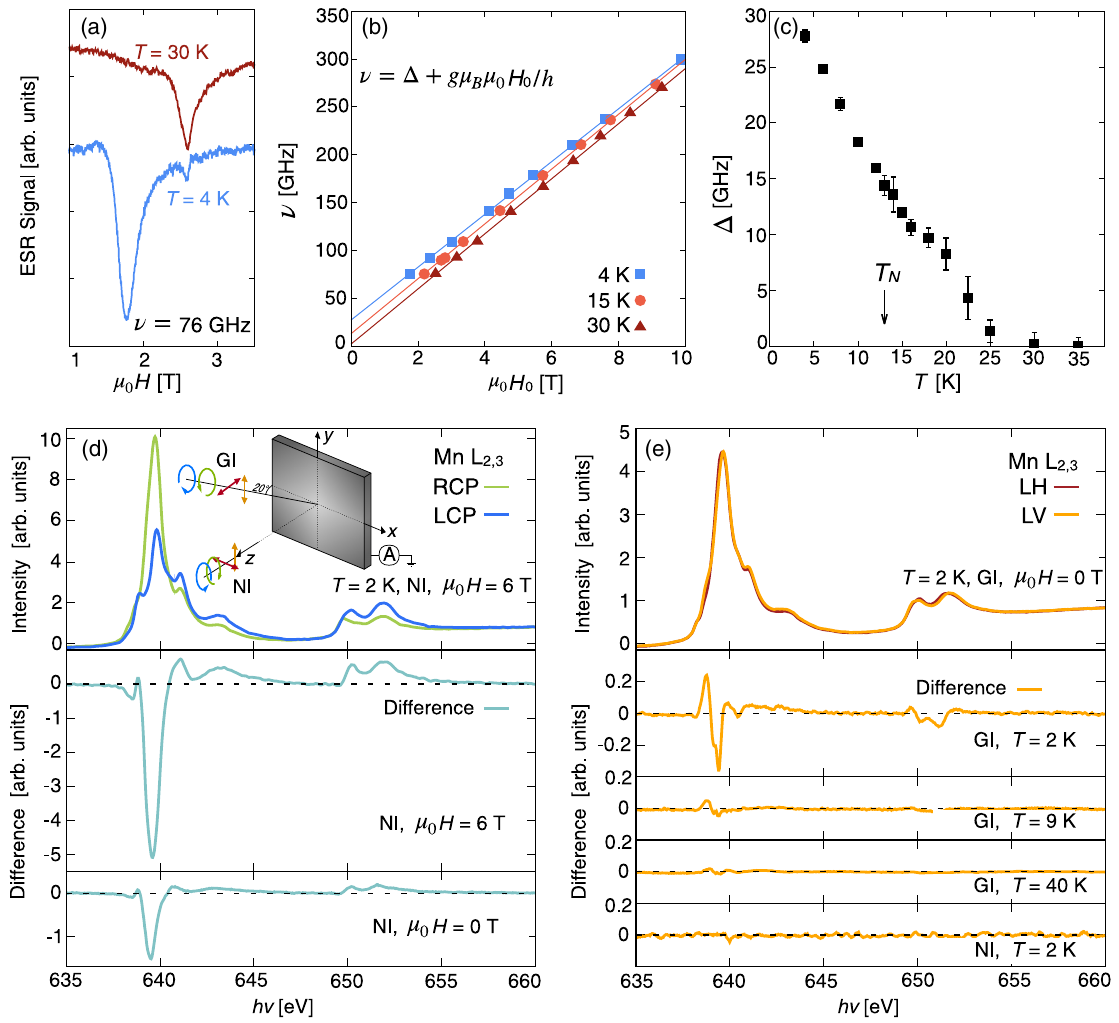
FIG. 3. Spectroscopy of magnetic properties in Mn147. (a) Typical ESR spectra measured at T ¼ 4 K and T ¼ 30 K. (b) Frequency dependence of the resonance field of the ESR signal measured at temperatures of 4, 15, and 30 K. (c) The anisotropy gap Δ as a function μ of temperature extracted from (a) by fitting ν ¼ Δ þ g μ 0 H 0 =h . (d) XMCD and (e) XMLD data for Mn147(0001) obtained at the B Mn L 2 absorption edge with circularly polarized (RCP and LCP) and linearly polarized (LVand LH) light, respectively. Measurements ; 3 are performed in normal (NI) and grazing (GI) light incidence geometries, as sketched in the inset of (d). XMCD signals are shown for an external field ( μ 0 H ¼ 6 T) along the light incidence direction and for remnant conditions ( μ 0 H ¼ 0 T) at T ¼ 2 K. (e) XMLD data without external field are reported for different